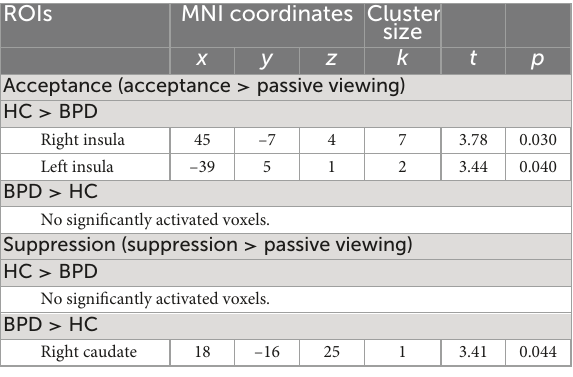
TABLE 3 Results of the regions of interest (ROI) analyses indicating acceptance-related bilateral insular underactivation and suppression-related right caudate overactivation in subjects with borderline personality disorder (BPD) during the emotion regulation